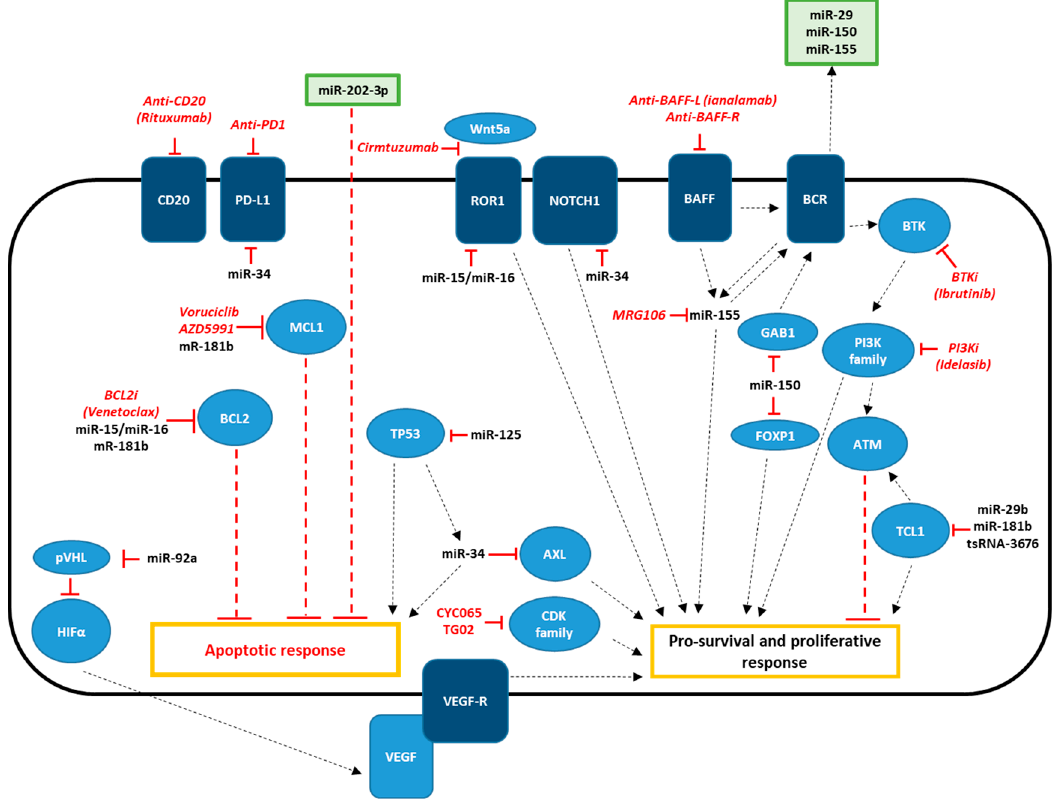
Figure 1. Schematic diagram of effectors, ncRNAs, and drugs involved in CLL therapy. NcRNAs are indicated in black, therapeutic agents are indicated in red. Surface receptors are indicated in dark blue and other effectors are indicated in light blue. Extracellular vesicles are indicated in green.